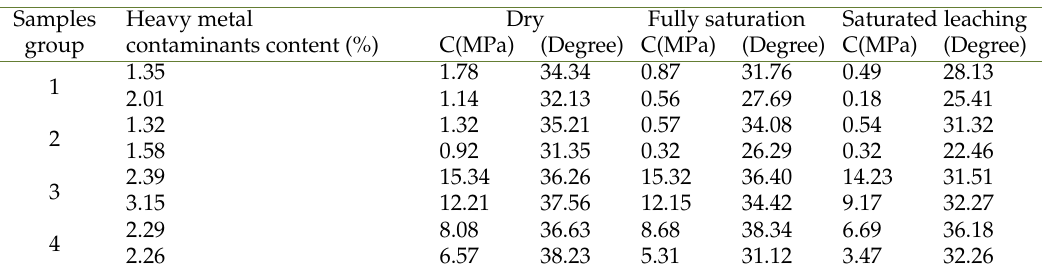
Table 1. The results of shear strength test